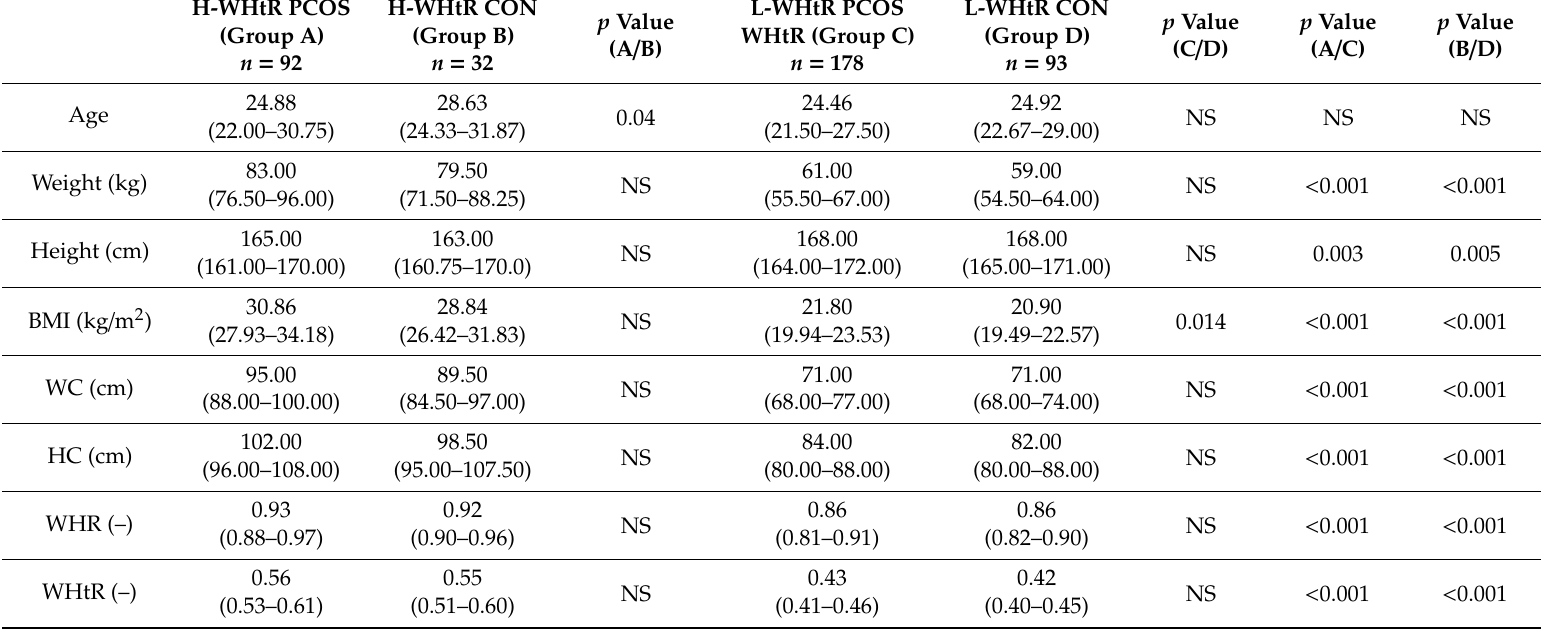
Table 1. Baseline anthropometric findings in the polycystic ovary syndrome (PCOS) patients and control (CON)